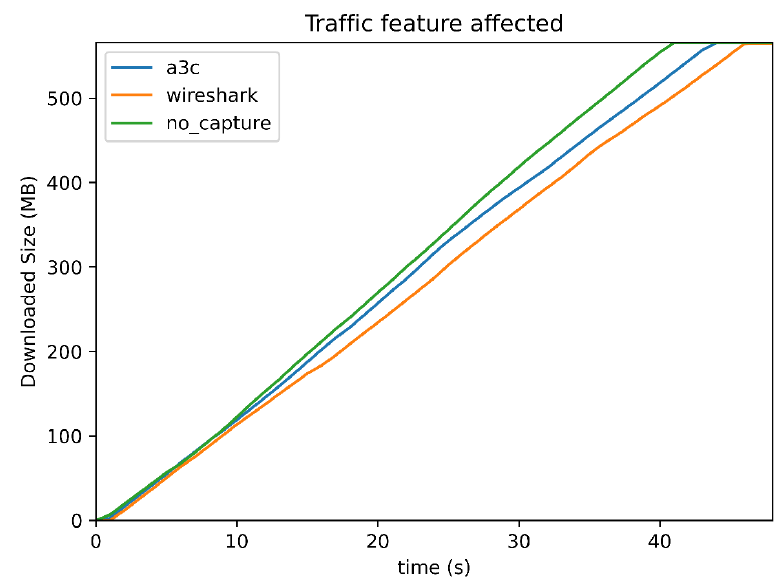
Figure 9. Comparison of network resource occupation in three